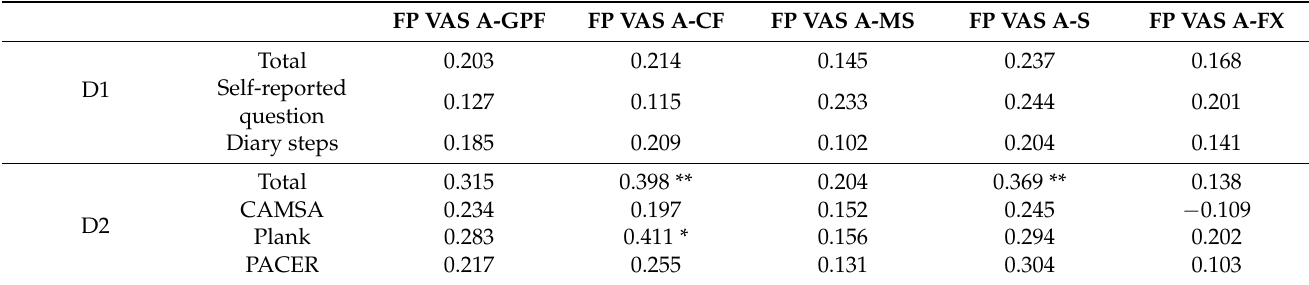
Table 4. Correlation between the domains of PL with the FP VAS A